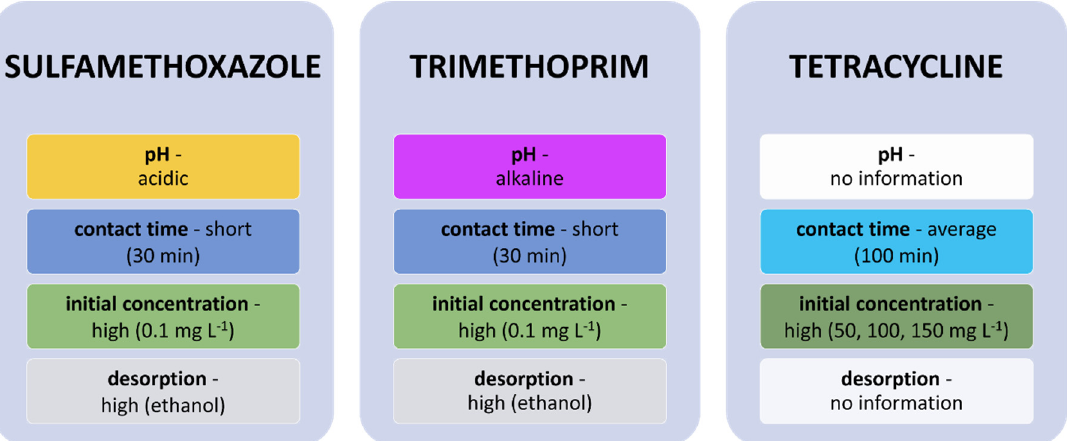
Figure 7. Factors influencing the sorption of sulfamethoxazole and trimethoprim on TMS-SBA-15 and tetracycline on A-MCM-41. Table 7. Comparative evaluation of adsorbent capacities for the removal of selected pharmaceuticals from aqueous solu- tions.